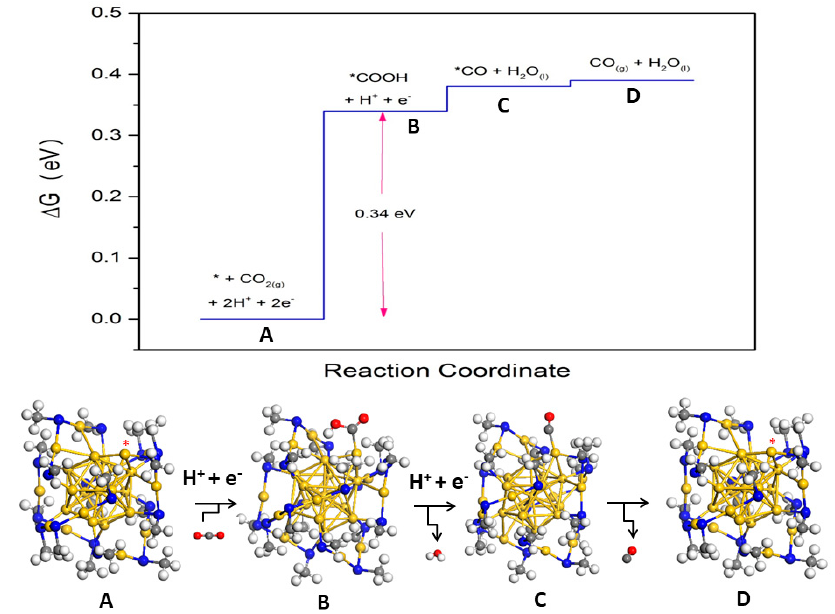
Figure 4. Free energy profile of the CO 2 reduction to CO on the dethiolated Au 25 (SCH 3 ) 18 - nanoclus- ter Adapted from Reference [52]. Copyright by the American Institute of Physics (2016). ocluster Adapted from Reference [52]. Copyright by the American Institute of Physics